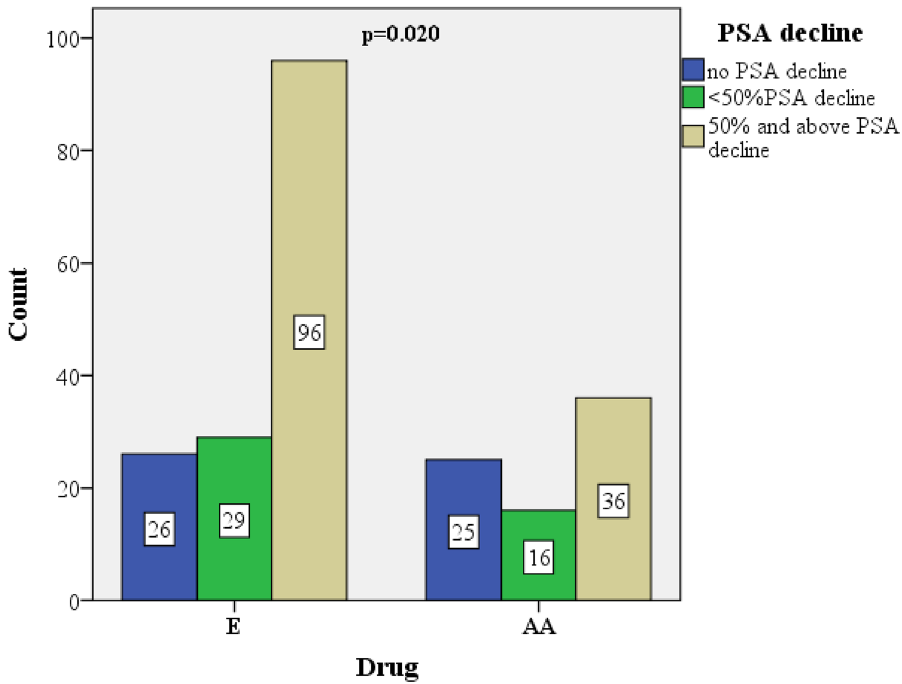
Figure 1. Comparison of PSA decline levels between drugs. PSA prostate-specific antigen E enzalutamide, AA abiraterone acetate.